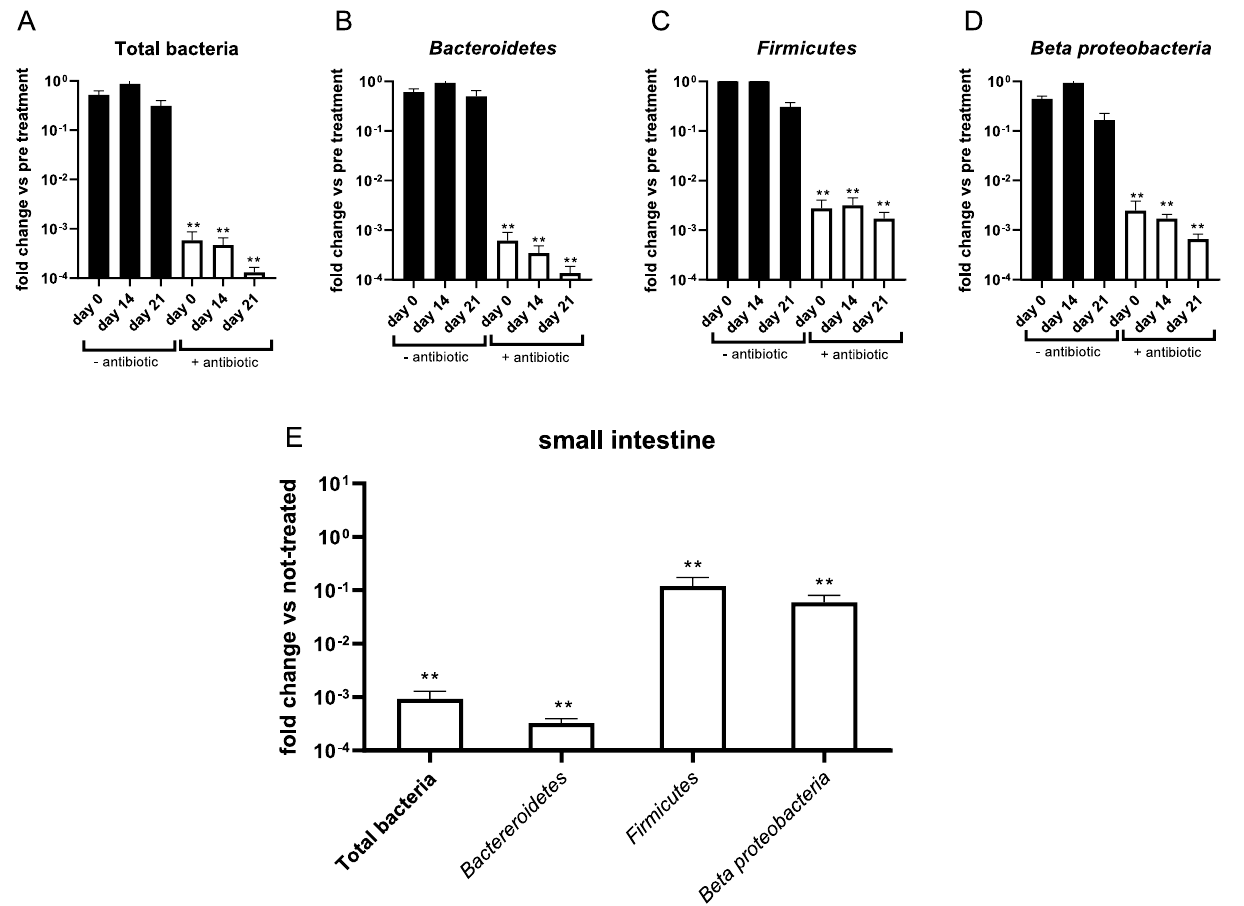
Figure 2. Effect of antibiotic treatment on the bacterial load in mice determined by qPCR on DNA extract of fecal ( A – D ) pellets and intestinal content ( E ). Results are shown for Total Bacteria, Bacteroidetes , Firmicutes and Beta proteobacteria as the mean of 5 mice with SEM errors bars. (**p ≤